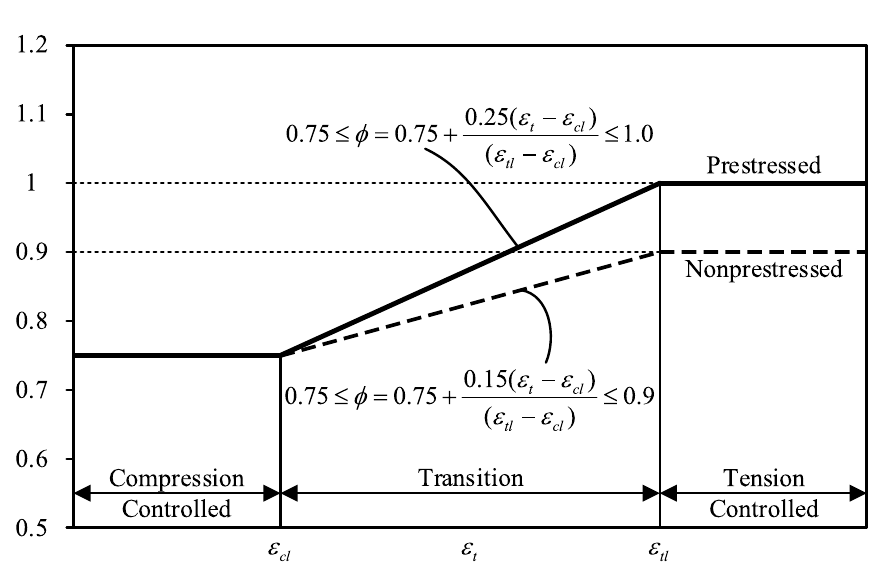
Fig. 2 Variation of φ with net tensile strain ε t for nonprestressed reinforcement and for prestressing